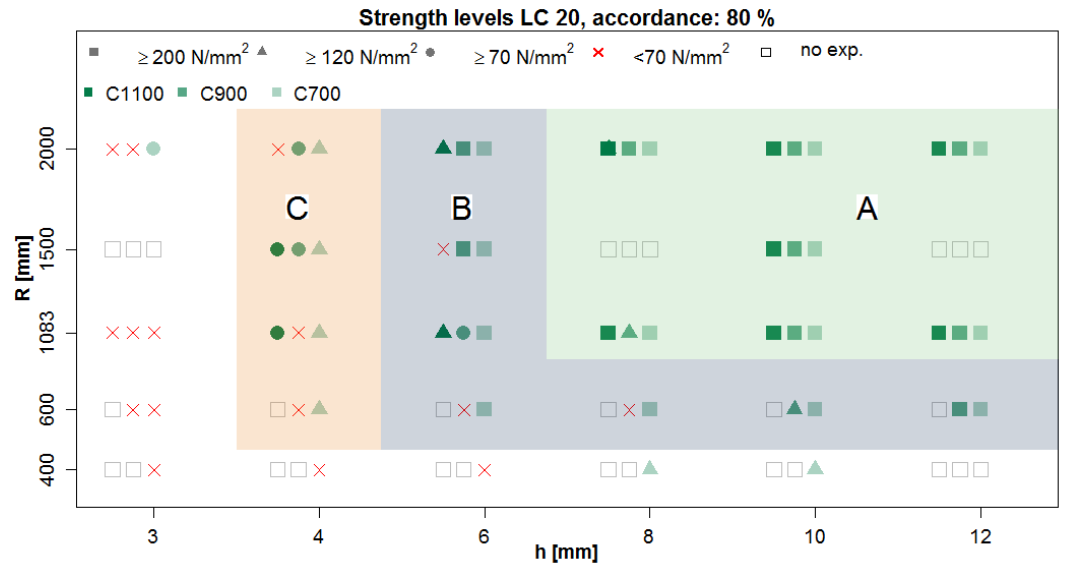
Fig. 11 Validation overview in dependence of the parameters radius and thickness, fixed width= 360